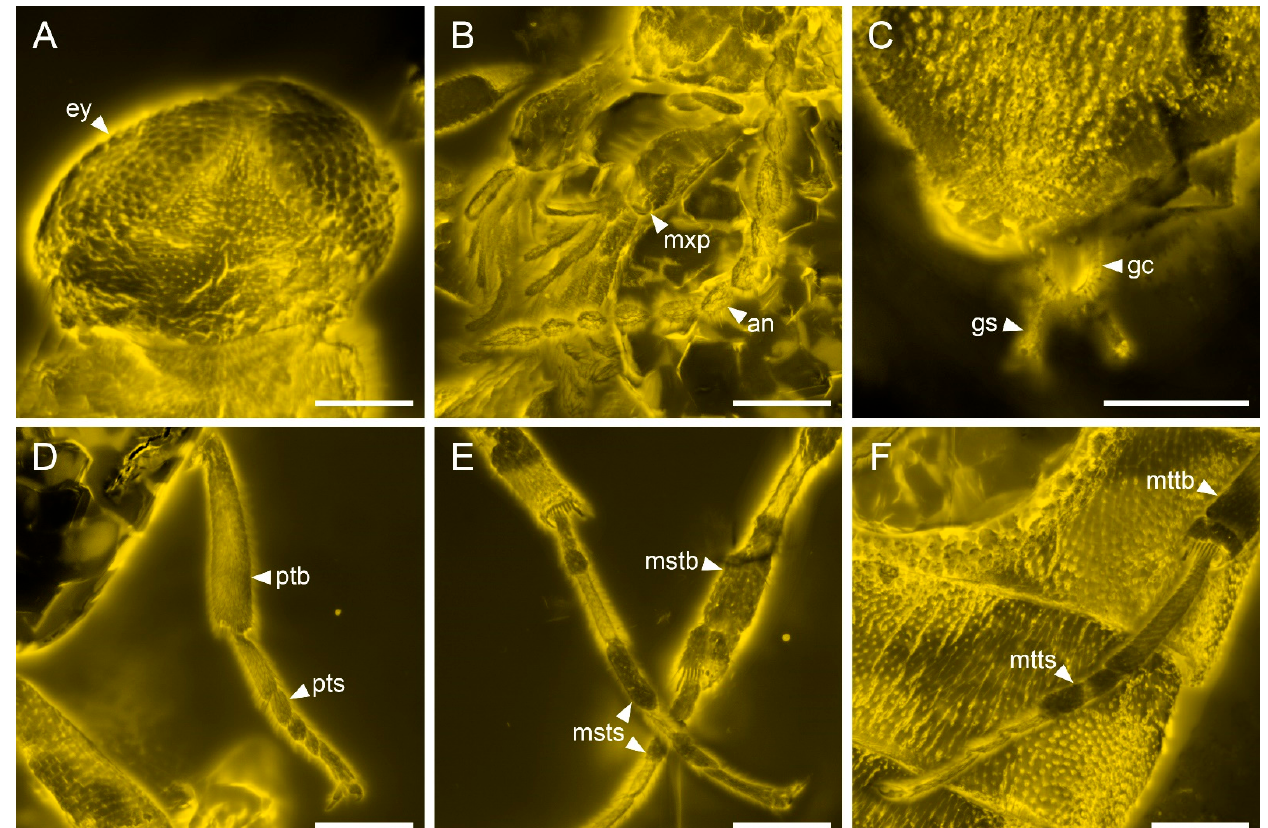
Figure 4. Details of Cretoquadratus fossilis (Yamamoto) comb. nov. , NIGP180657, under confocal microscopy. ( A ) Head, dorsal view. ( B ) Antenna and maxillary palps. ( C ) Ovipositor, dorsal view. ( D ) Fore leg. ( E ) Mid legs. ( F ) Hind leg. Abbreviations: an, antenna; ey, compound eye; gc, gonocoxite; gs, gonostylus; mxp, maxillary palp; mstb, mesotibia; msts, mesotarsus; mttb, metatibia; mtts, metatarsus; ptb, protibia; pts, protarsus. Scale bars: 200 μ m.